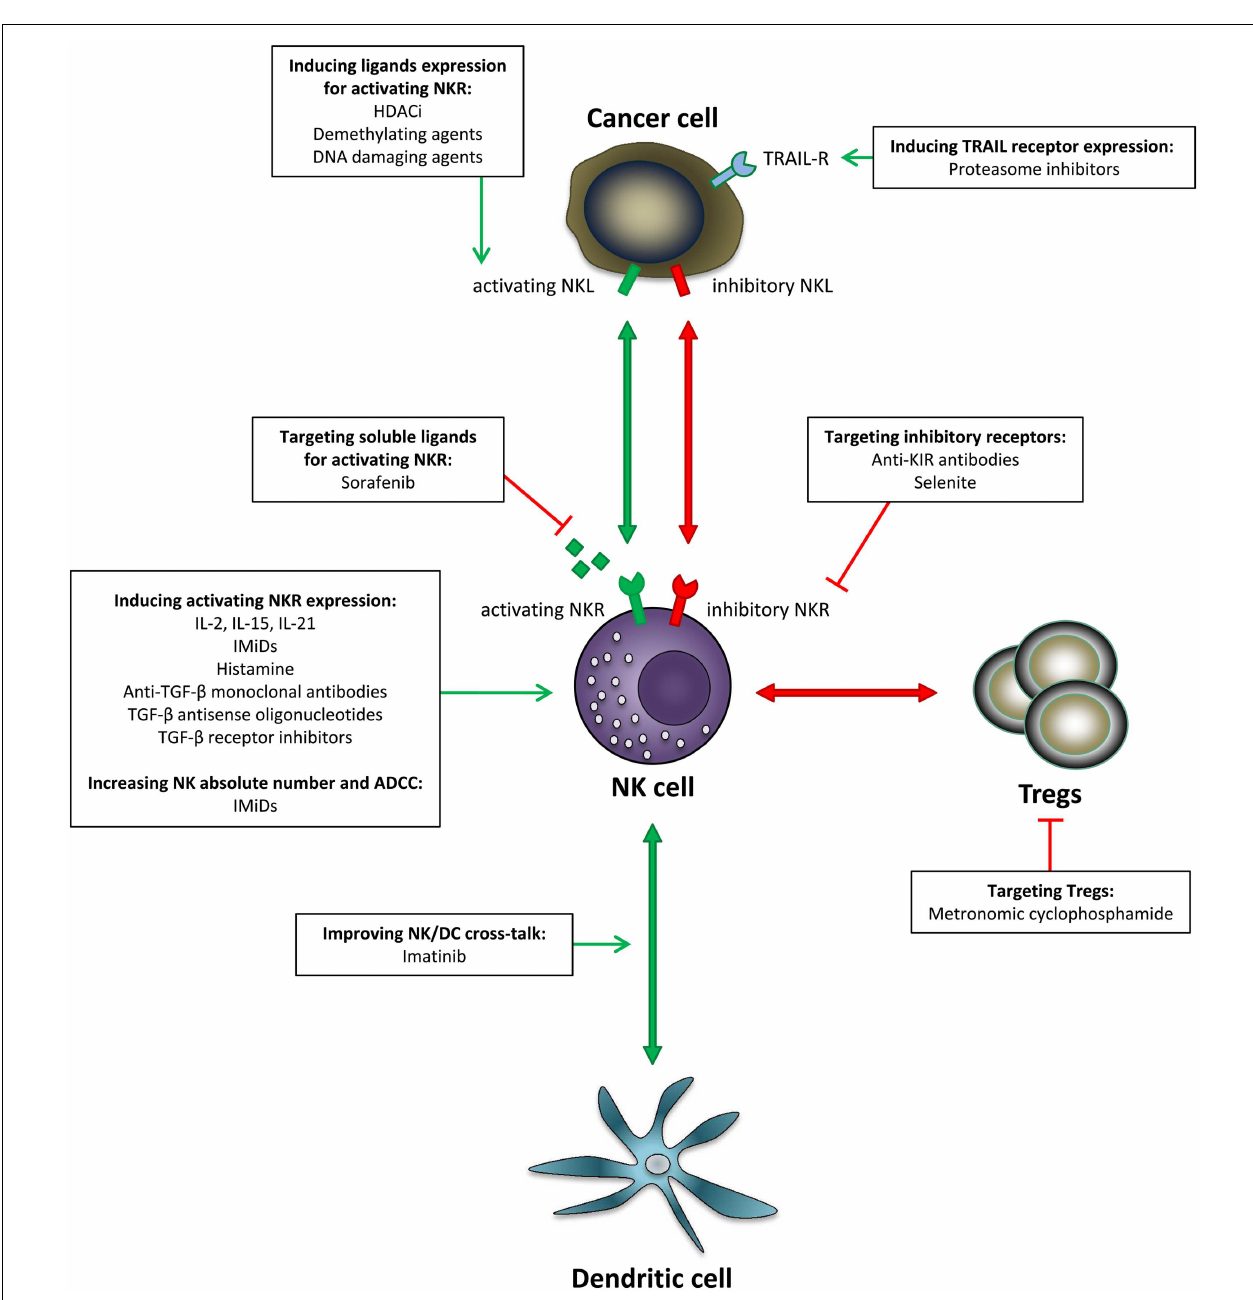
FIGURE 1 | Pharmacological strategies aiming at improving NK anti-tumor functions .Various options have been developed to restore NK cell functionality in cancer: induction of NK triggering receptors, induction of NK ligands expression on the target cells, blockade of inhibitory signals, as well as stimulation of NK/DC crosstalk. In addition, increasing NK number and improving ADCC can enhance this effect. NKL, natural killer ligand; NKR, natural killer